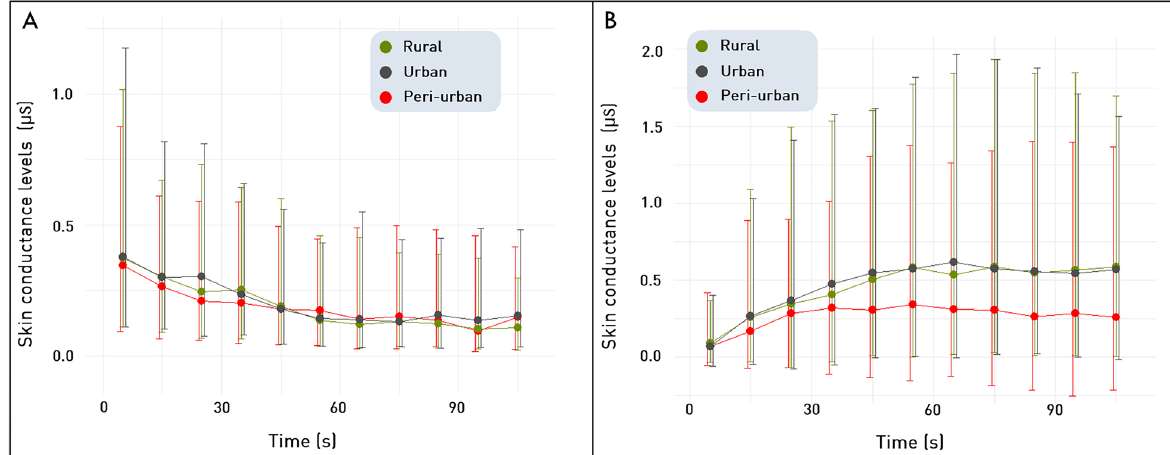
Figure 1. Physiological arousal measured by skin conductance responses (ΔSCL between baseline and stimulus) across the rural, urban and peri-urban scenes, with ( A ) phasic signal, and ( B ) tonic signal. Error bars represent the first and third quantiles of the dataset across 285 participants exposed to one of the two sets of stimuli from each type of residential landscapes (urban, peri-urban, and rural) in Switzerland and the